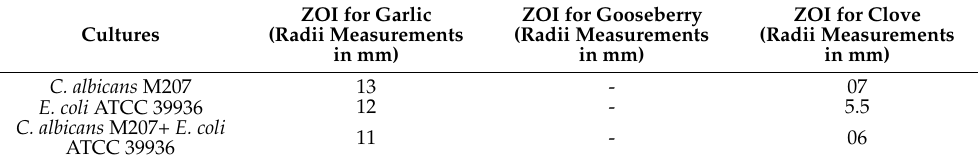
Table 1. ZOI for whole aqueous extracts measured by Agar well diffusion method.